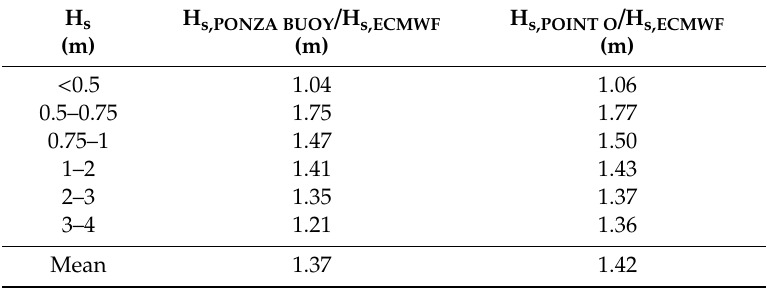
Table 3. Average di ff erences between the buoy records (at Ponza and transposed at point O, respectively) and ECMWF hindcast data for point E3.